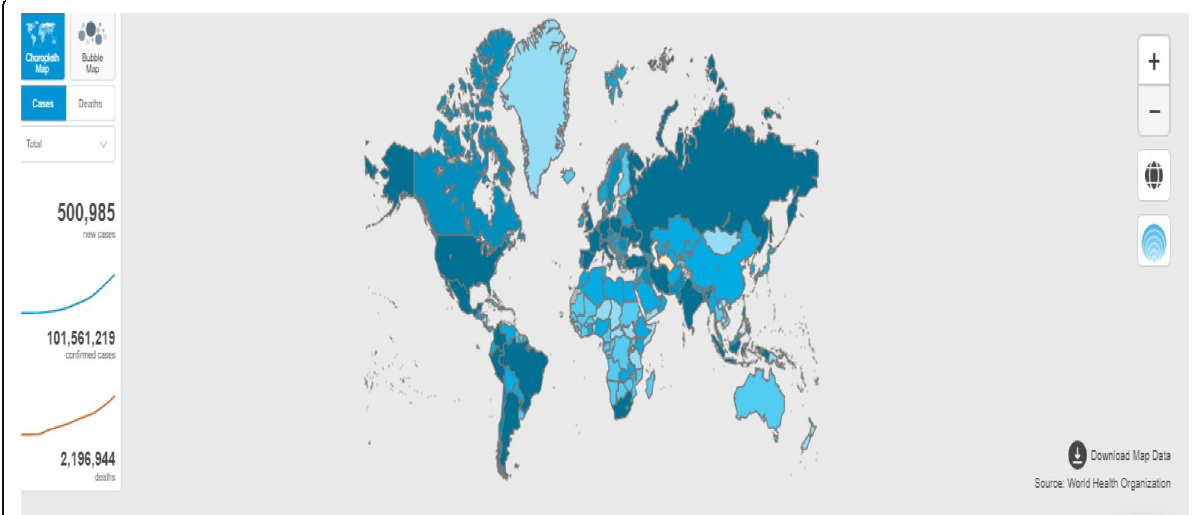
Fig. 1 Global COVID-19 spread showing number of confirmed cases as of 30 January 2021 (Source: